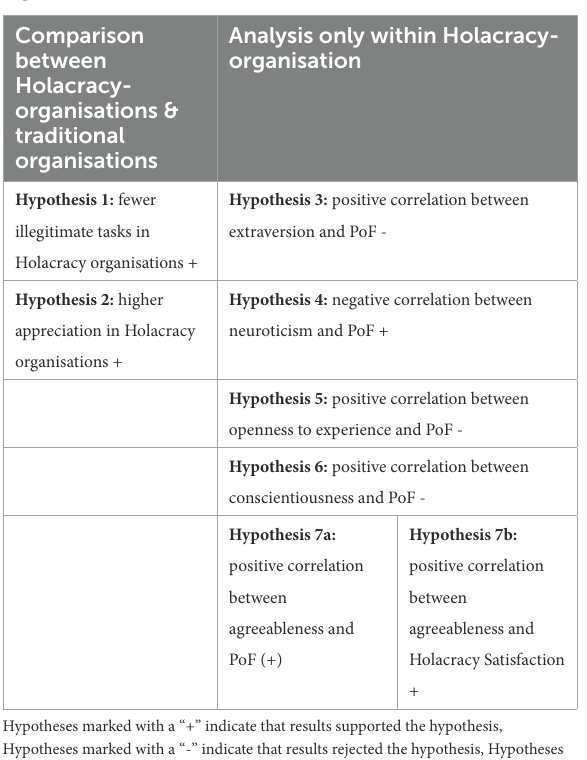
traditional organisations and analysis only within holacracy organisations.